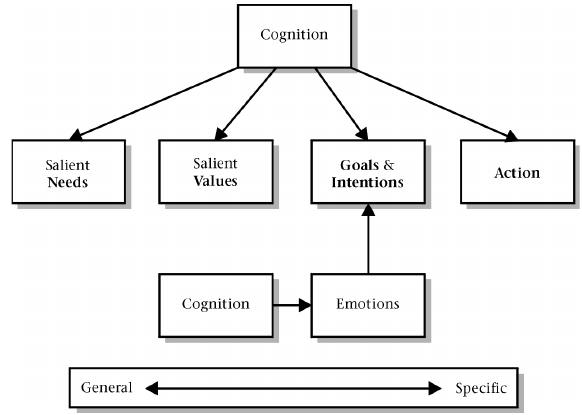
Figure 3: A basic motivational process (adapted from Locke & Henne, 1986, p. 2)